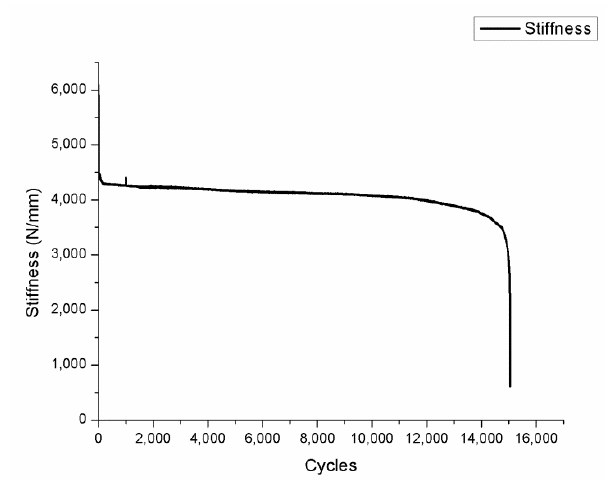
Figure 7. Stiffness–cycles curve ( ρ = 0.4 g/cm 3 , Fm = 3700 N).